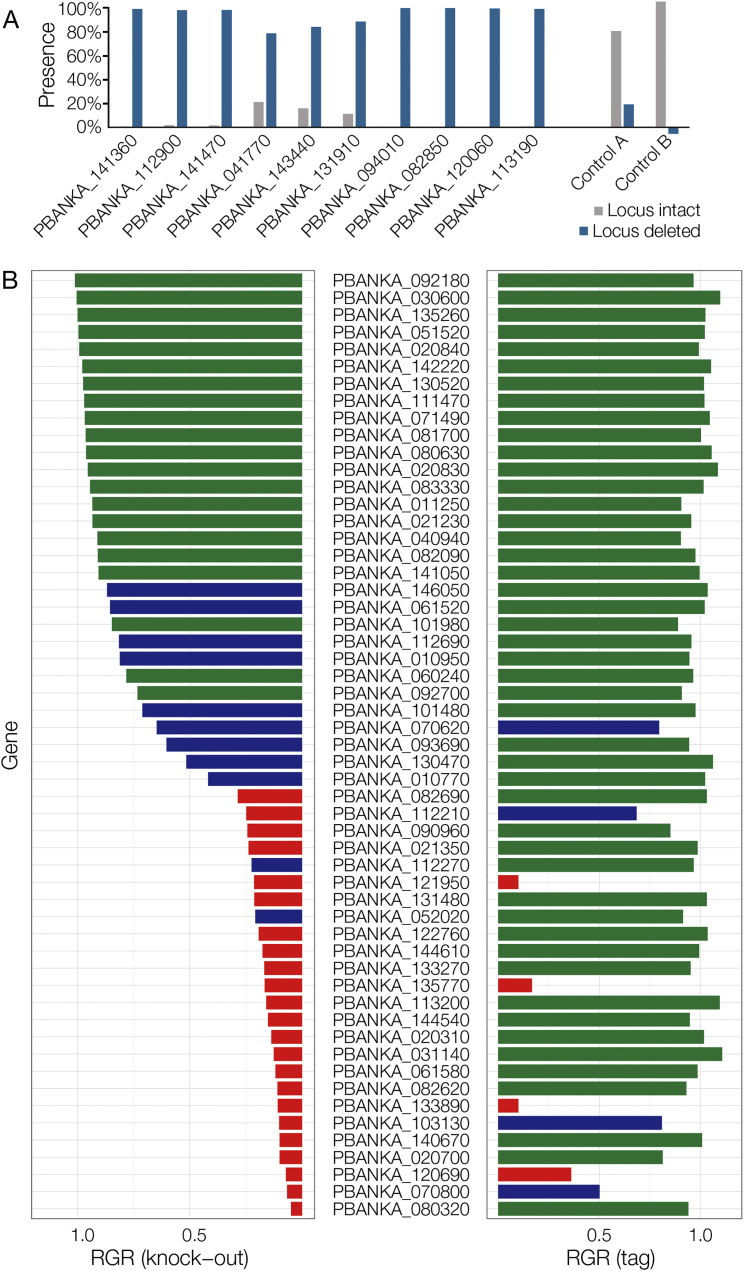
Validation of Dispensable and Essential Phenotypes, Related to Figure 2(A) For 10 genes whose disruption had previously failed (RMgmDB), quantitative PCR was used to measure the proportion of parasites that retained the wild-type locus following transfection of individual deletion vectors. In each case the population was dominated by viable mutant parasites, validating the screen result. Controls A and B show a reciprocal primer swap for mutants in PBANKA_082850 and PBANKA_120060.(B) Relative growth rates were determined using KO or C-terminal tagging vectors for the same set of genes. Phenotype calls are color coded. Green = RGR not significantly different from of 1. Red = RGR not significantly different from 0.1 Blue = Intermediate RGR.